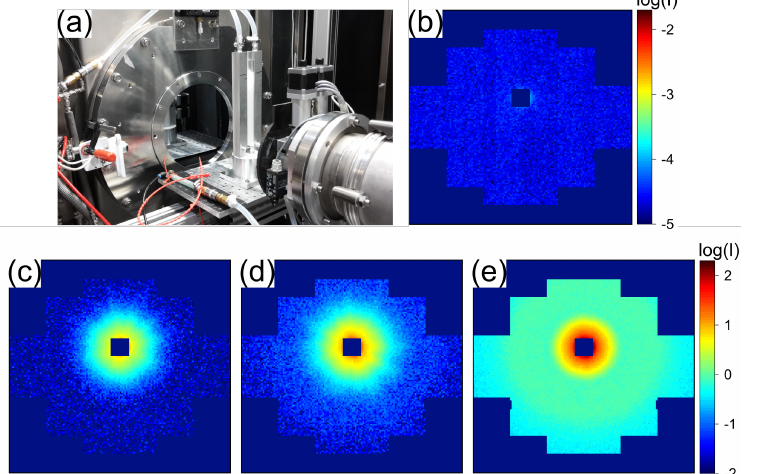
Figure 6. ( a ) Single foam cell installed at the KWS-1 beamline at the MLZ. ( b ) 2D SANS data of an empty quartz foam cylinder. ( c – e ) 2D SANS data of a steady-state foam produced from a 25gL − 1 SDS solution at 16cm ( c ), 9.5cm ( d ), and 2cm ( e ) foam height above the foaming solution. All experiments were carried out at a sample–detector distance of 7.615m. Data acquisition time was